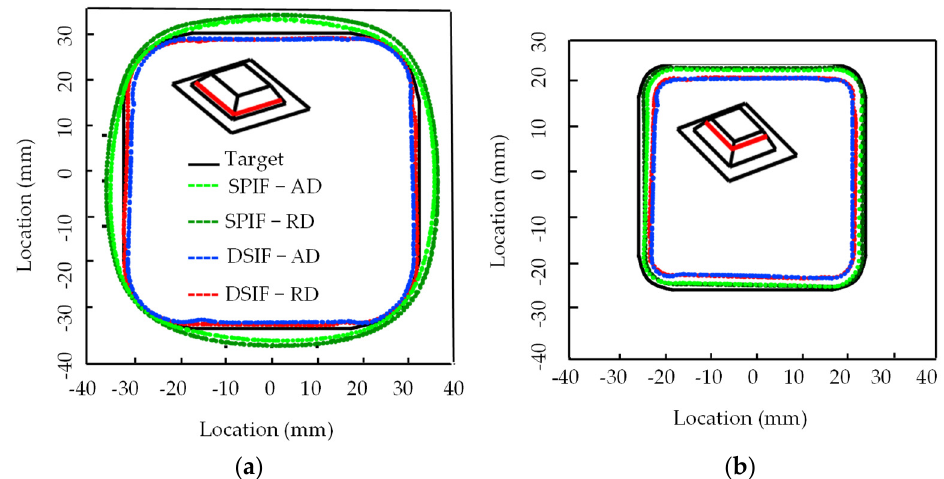
Figure 14. Horizontal cross-sectional shapes of formed sheet at different heights; ( a ) height = 3 mm ( b ) Height = 12 mm, where AD is advancing (clock-wise) direction, RD is retreating (anti-clockwise) direction (reprinted with permission from Otsu et al. [29], Copyright 2018 Elsevier).